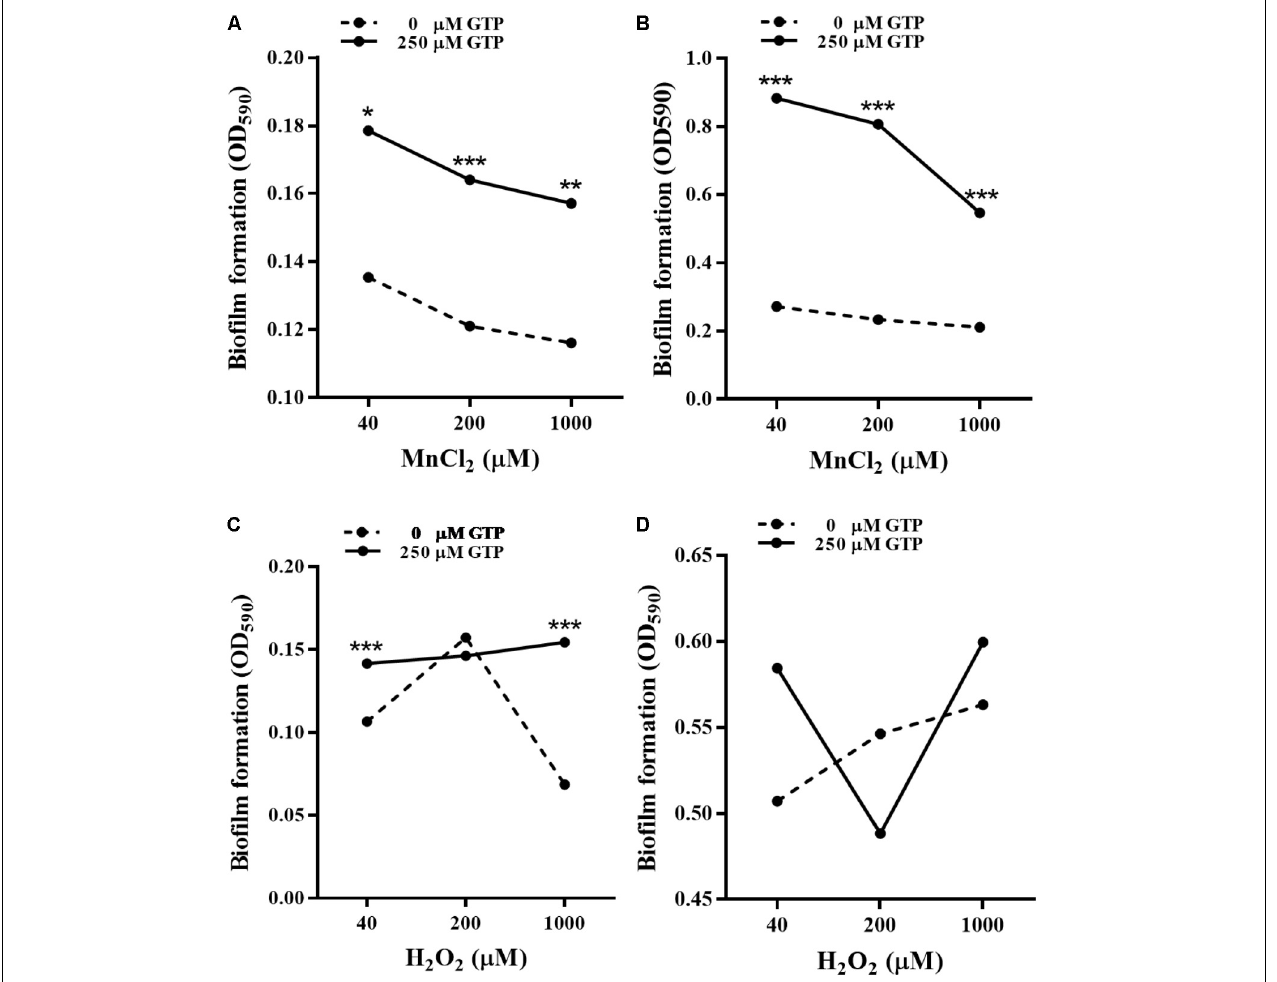
FIGURE 9 | Effect of GTP on biofilm formation by P. putida MnB1. Microbes were incubated with Mn 2 + at 40, 200, and 1000 µ M for 6 h (A) and 12 h (B) in the presence or absence of 250 µ M GTP ( n = 6), respectively. Microbes were incubated with H 2 O 2 at 40, 200, and 1000 µ M for 6 h (C) and 12 h (D) in the presence or absence of 250 µ M GTP ( n = 6), respectively. Biofilm formation of P. putida MnB1 was quantified by CV staining with absorbance at 590 nm. Data were expressed as mean ± SEM. Significance, ∗ P < 0.05, ∗∗ P < 0.01, and ∗∗∗ P < 0.001 vs. control group (0 µ M